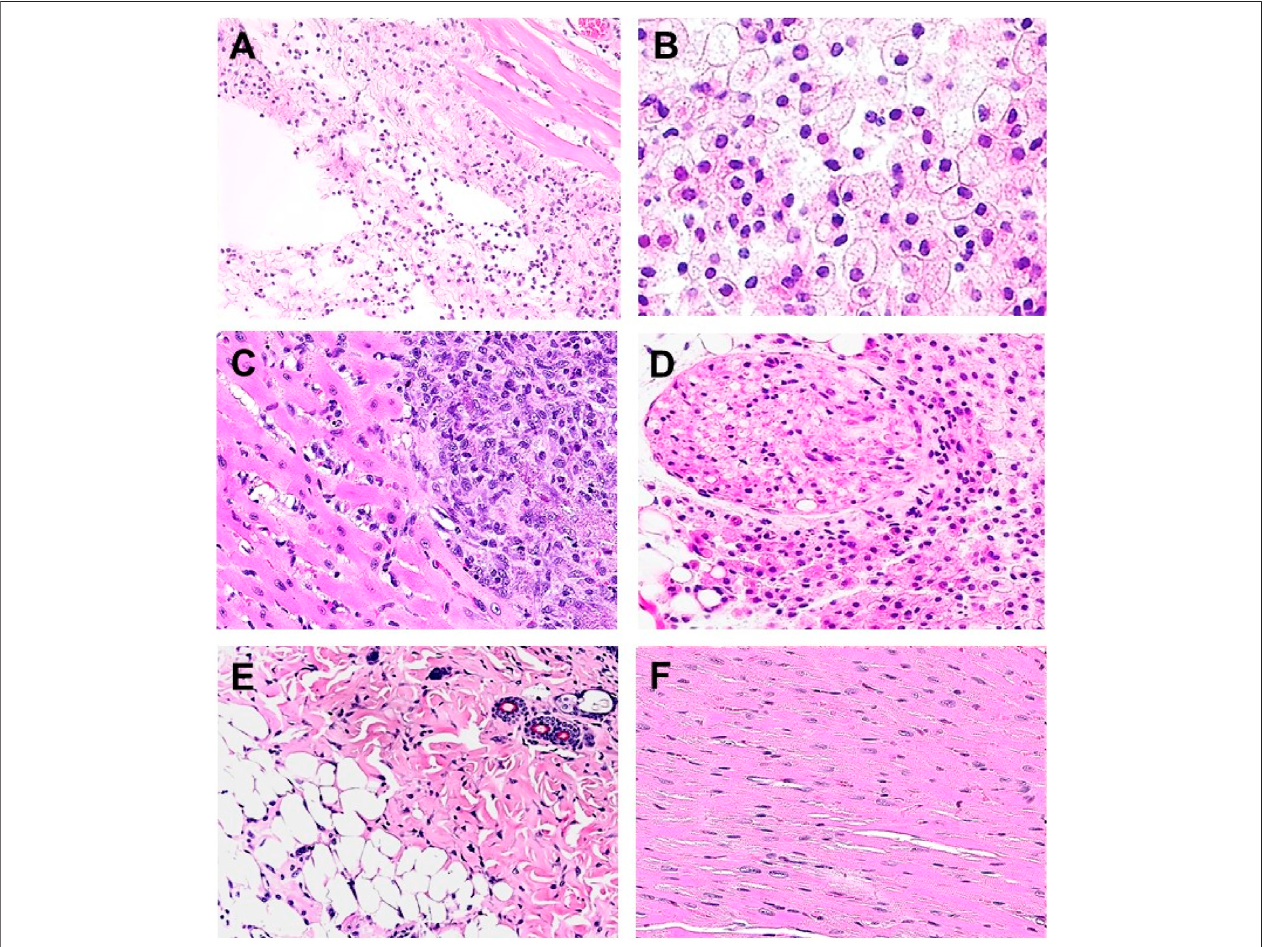
FIGURE 3 | Recruitment of macrophages into various tissues of anti-Gal – producing α 1,3galactosyltransferase knockout (GT-KO) mice, injected with α -gal nanoparticles. (A) Macrophagerecruitment24 hafterintradermalinjectionof α -galnanoparticles(10 mg).Theemptyareaistheinjectionsiteinwhich α -galnanoparticles were eliminated by alcohol fi xation (H&E × 100). (B) Skin specimen, 7 days post intradermal injection of α -gal nanoparticles. Macrophages are large with ample cytoplasm (H&E × 400). (C) Macrophages recruited into post-MI myocardium 7 days post injection (H&E × 200). (D) Macrophages recruited to a branch of